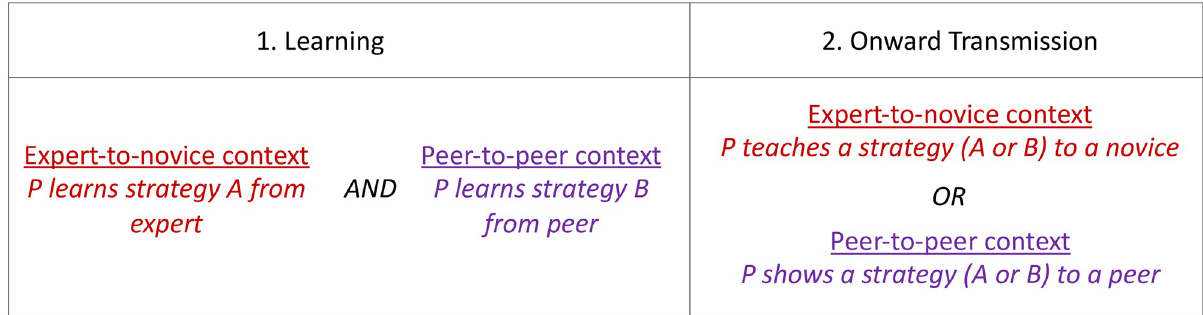
Fig 3. Experimental design showing what a participant P learns and transmits